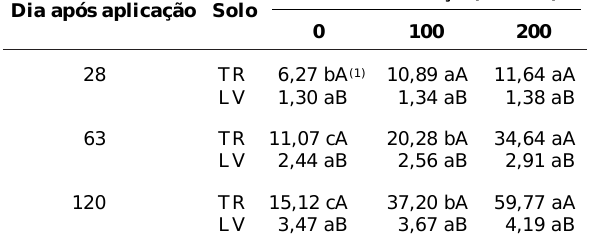
tos a 0,01 de significância pelo teste t.